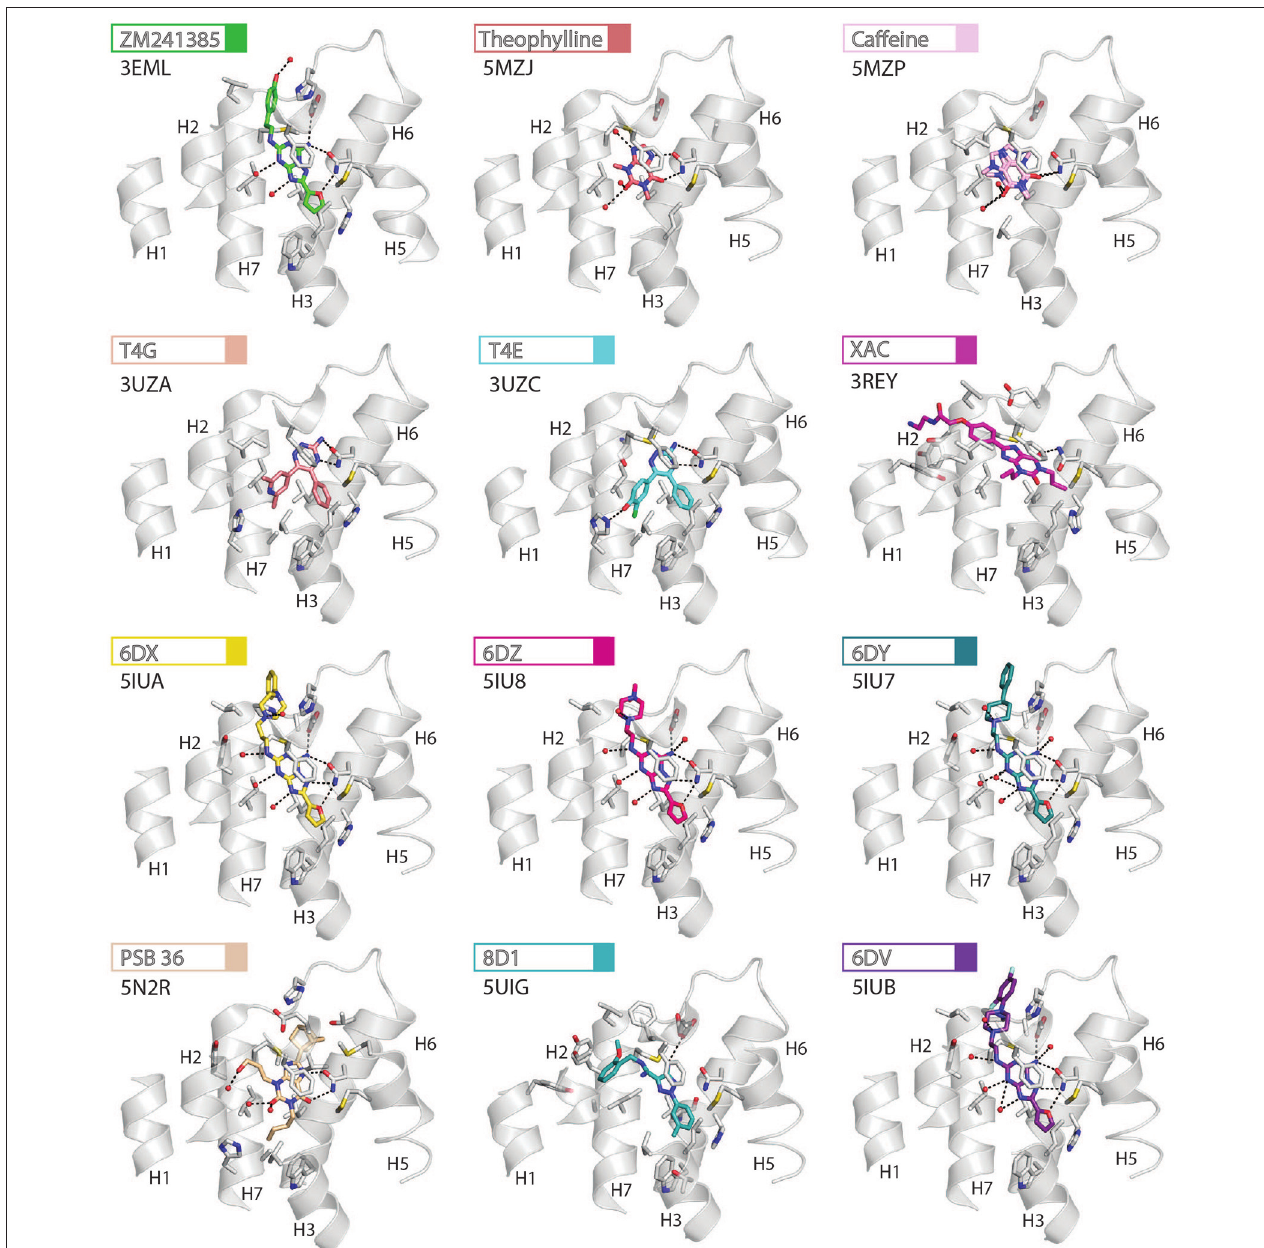
FIGURE 4 | High-resolution view of the antagonist- or inverse agonist- binding site of human A 2A R. Twelve different antagonists or inverse agonists have been co-crystallized with A 2A R, in the inactive conformation. The receptor is shown as cartoons and colored gray, residues and side chains that interact with the ligand are shown as sticks and colored by element (carbon, gray; nitrogen, blue; oxygen, red; sulfur, yellow). The ligands are shown as sticks and their carbon atoms are colored to match their labels, PDB codes are shown in the figure. Polar contacts are represented as dashed lines and water molecules are shown as red spheres. Note that for caffeine the two distinct binding orientations that were observed in the structure are overlaid.